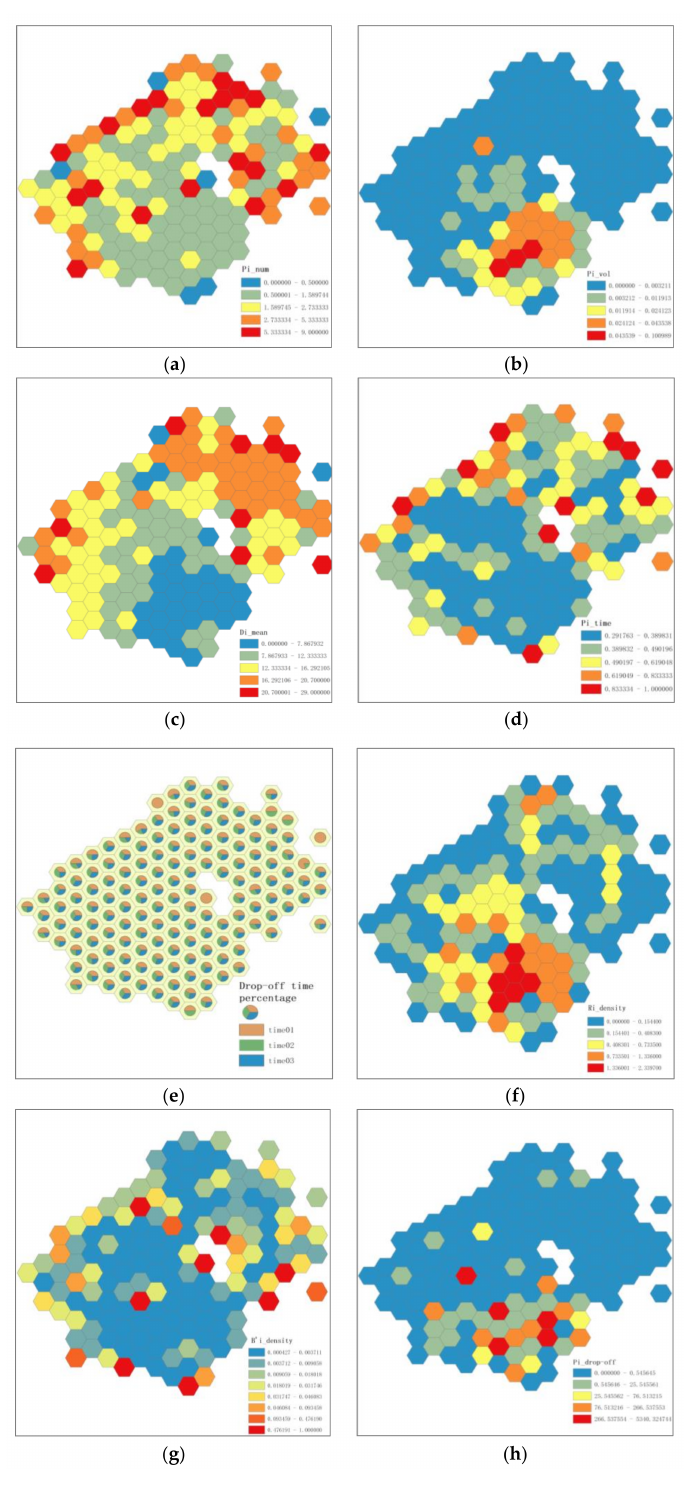
Figure 11. ( a , b ) Calculated result of the L1 and L2. ( c ) ATD of each hexagonal grid. ( d ) Calculated result of L3. ( e ) Distribution of the number of trips in each study area in the first three hours. ( f ) Density of road net. ( g ) Reciprocal of bus line density. ( h ) Final result of the